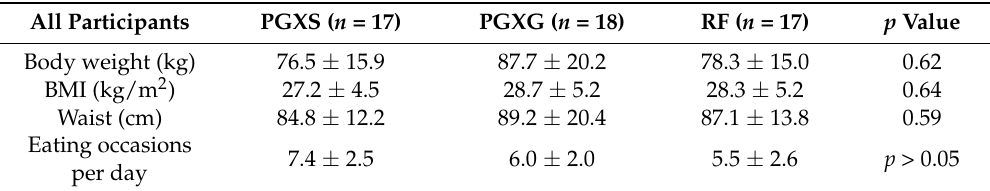
Table 3. Characteristics of study participants randomised at baseline ( n = 54) comparing subgroups who consumed the recommended dose of fibre supplements.